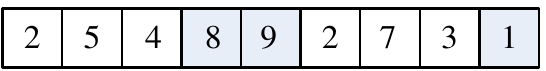
Fig.4 Successivemultiplevirtualsegmentsinsegmentgenestructure